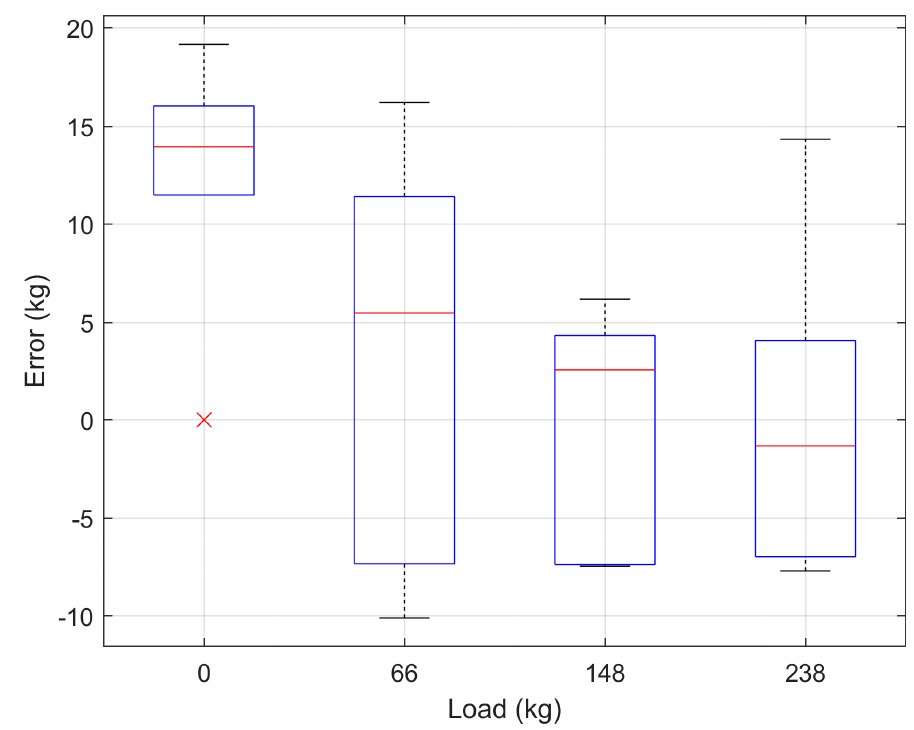
Figure A5. Dependencies between a car load and the load parameter for a three-door Volkswagen Polo. Dots represent measurements; circles stand for chosen to calibrate values of the measured load parameter (for a car and load); and line show the least squares fit to the chosen measurements (i.e., circles).